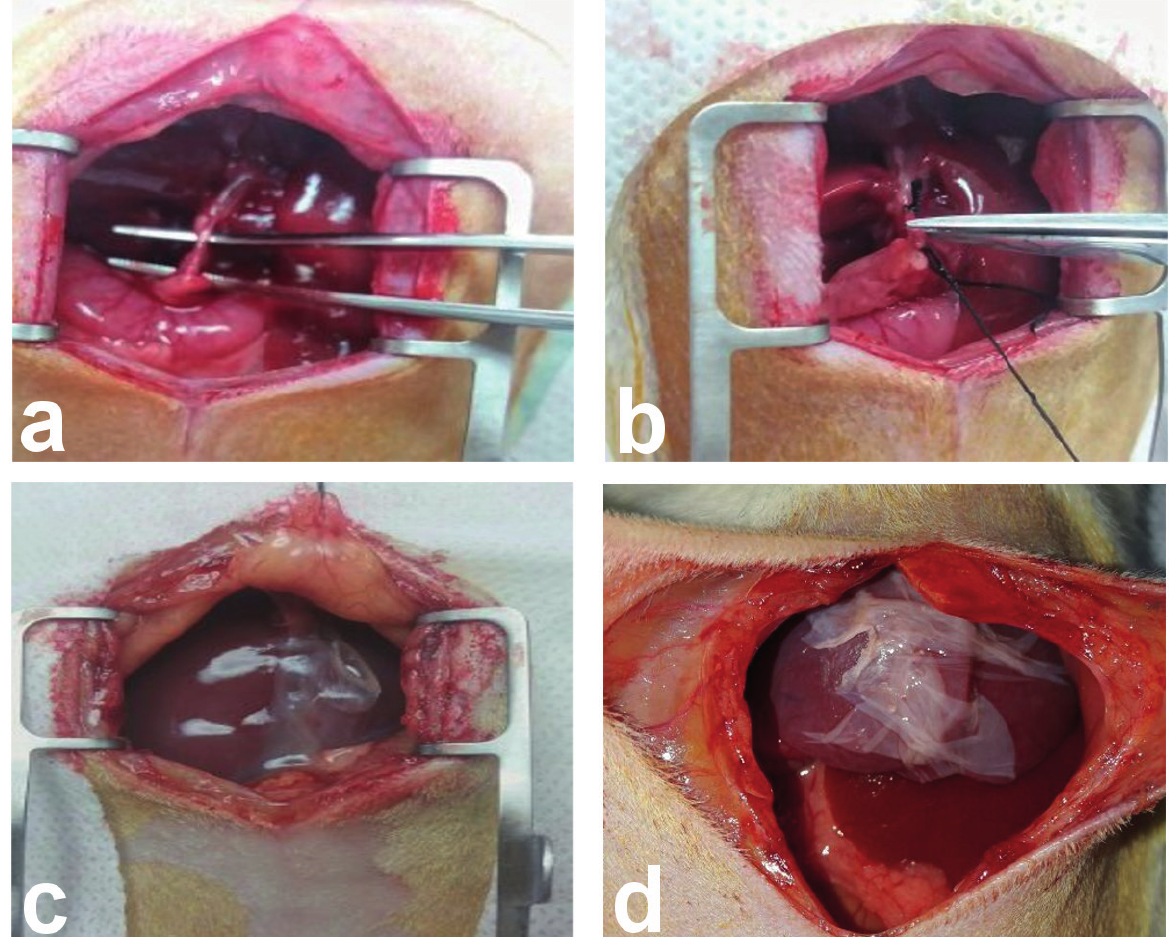
Figure 1 - Bile duct ligation: exposure of the bile duct ( a ); Bile duct ligation ( b ); Application of Am around all lobes of the liver – Group Bdl+Am ( c ); Application of Am around the medial lobe – Group Bdl+Am 0